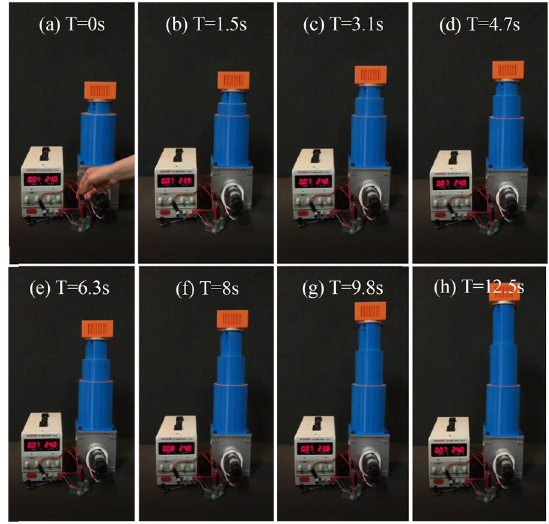
Figure 19 TTM working sequence with